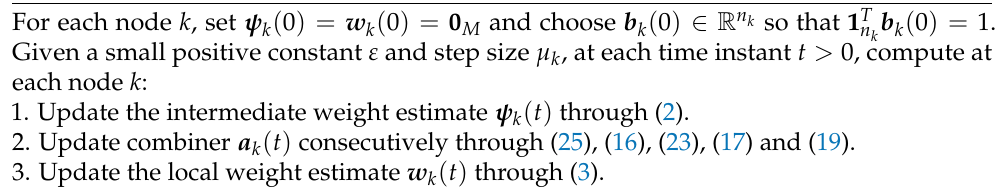
Algorithm 1 ATC with the proposed AC